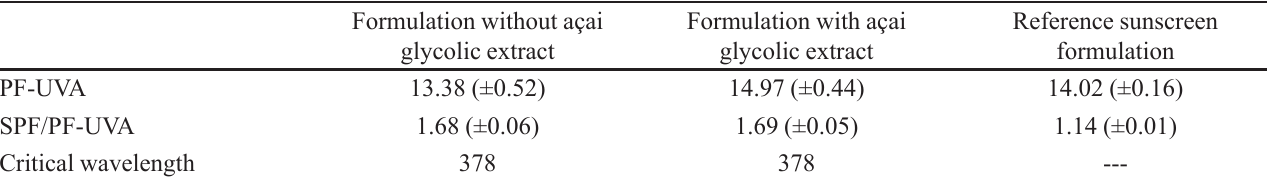
TABLE V – In vitro UVA protection factor (PF-UVA), SPF/PF-UVA and critical wavelength (nm) determinations of the O/W sunscreen emulsion with (R2) and without açai glycolic extract Formulation without açai glycolic